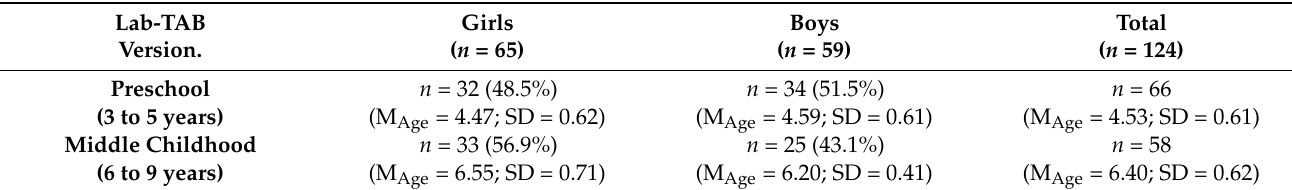
Table 1. Participants’ distribution according to the Laboratory Temperament Assessment Battery (Lab-TAB) version: gender and age. Lab-TAB